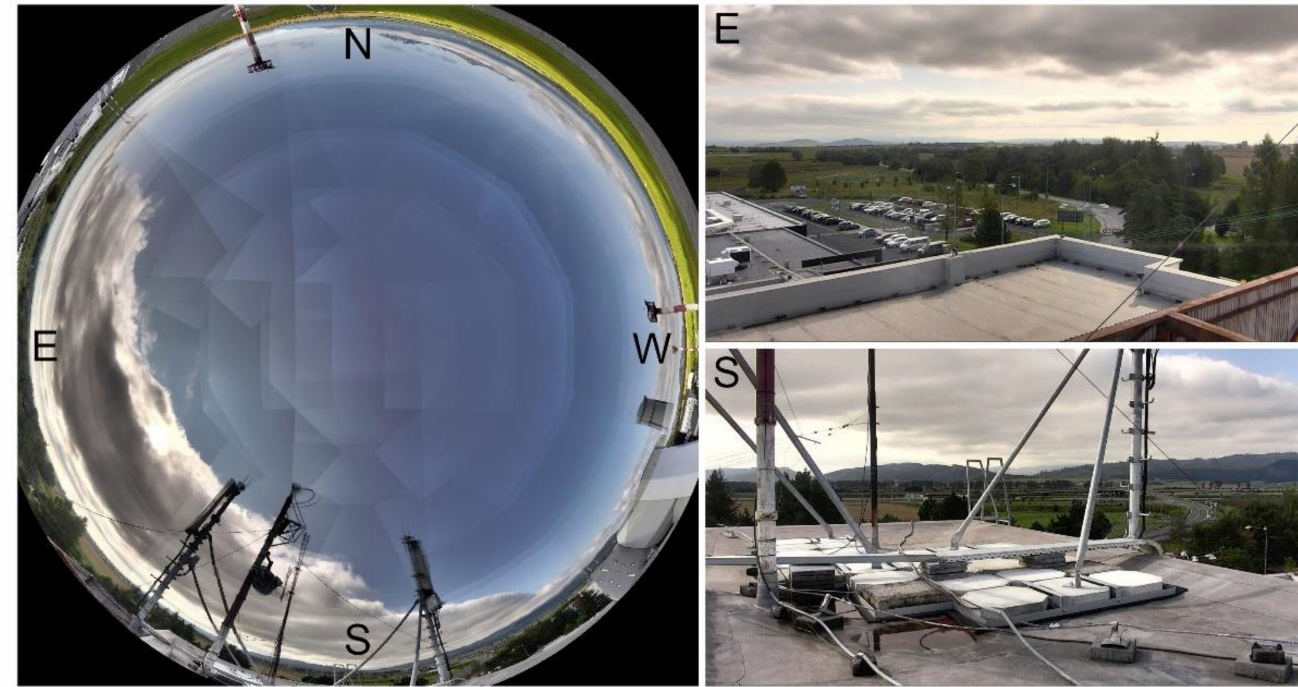
Figure 12. The same as Figure 9, but for 27 August 2018, at 07:20 UTC. Table 7. The same as Table 4, but for 27 August 2018, at 07:20 UTC. BKN—Broken, SCT—Scattered. AWOS RO LO Maximum cloud